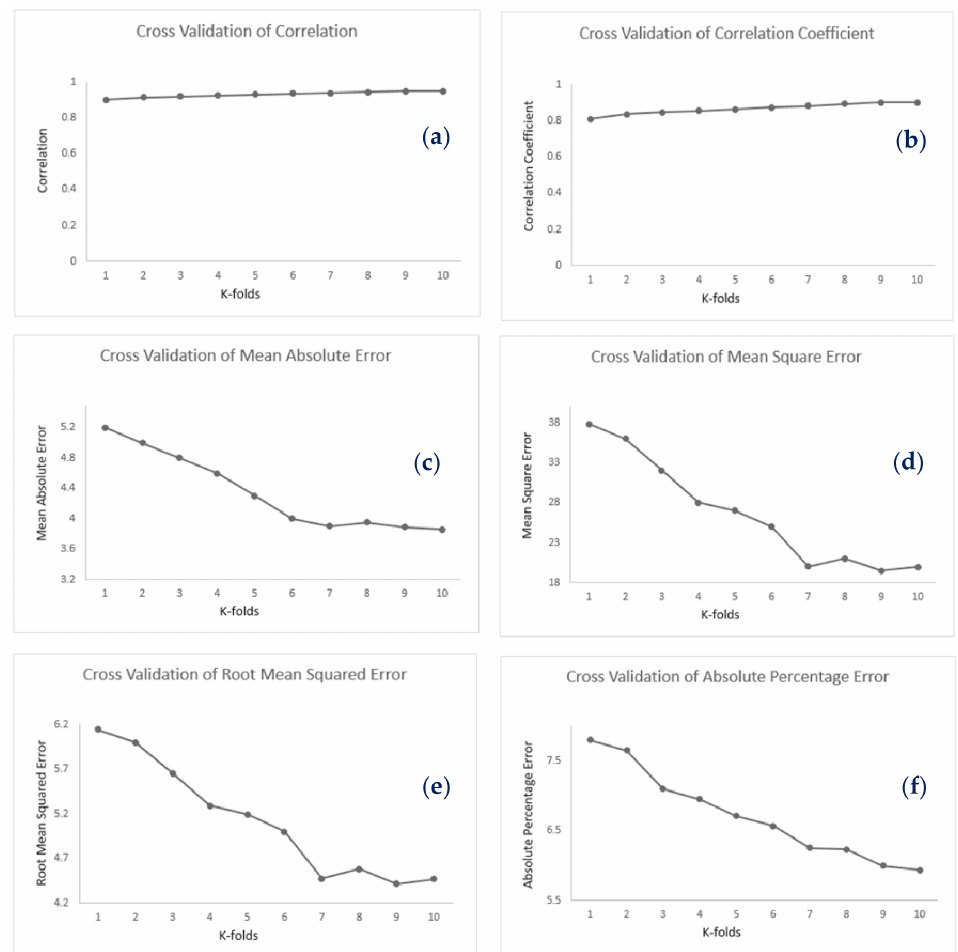
Figure 12. 10-fold cross-validation of ( a ) R , ( b ) R 2 , ( c ) MAE , ( d ) MSE , ( e ) RMSE , and ( f ) MAPE in predicting L eq using the testing dataset by RF